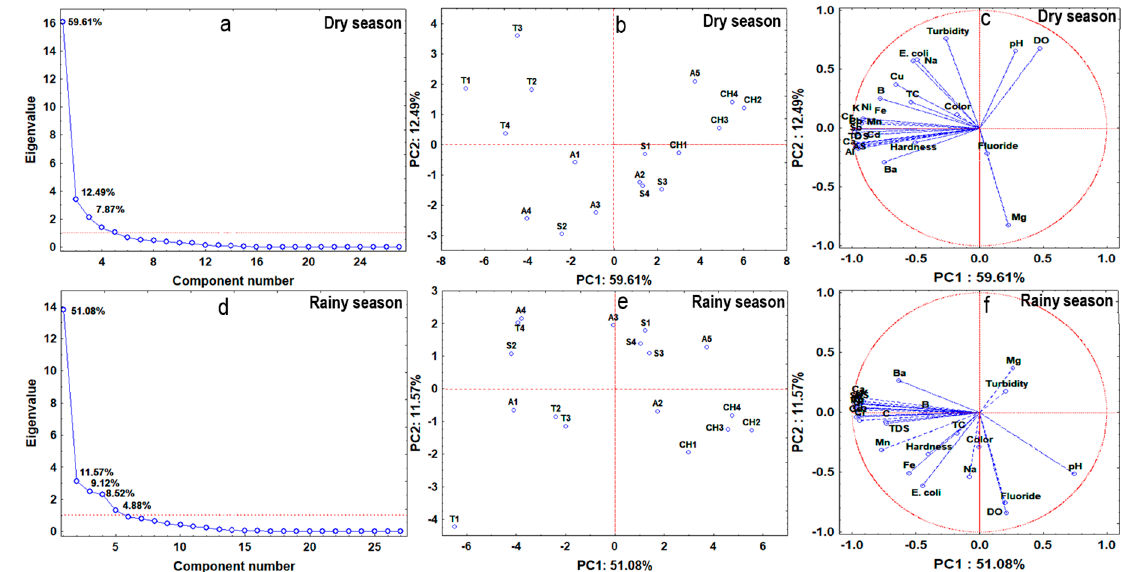
Figure 8. ( a ) Scree plot for the dry season, ( b ) scores plot for PC1 and PC2 in the dry season, ( c ) loadings plot for PC1 and PC2 in the dry season, ( d ) scree plot for the rainy season, ( e ) scores plot for PC1 and PC2 in the rainy season, and ( f ) loadings plot for PC1 and PC2 in the rainy season. Table 7. Rotated component matrix by season.